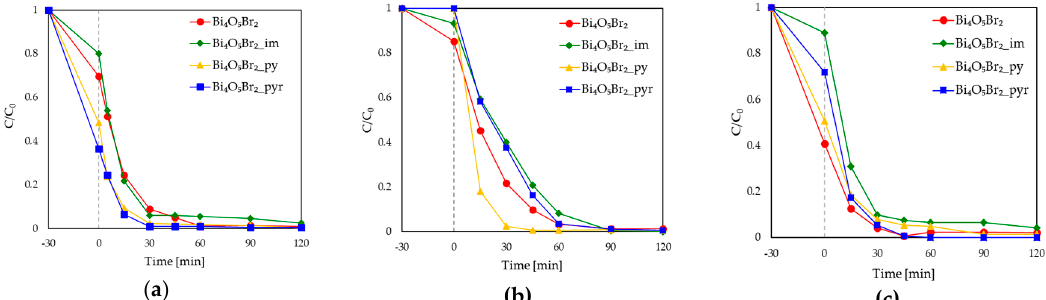
Figure 1. Photocatalytic activity of prepared photocatalysts toward ( a ) Rhodamine B, ( b ) 5- fluorouracil and ( c ) chromium (VI) under artificial solar